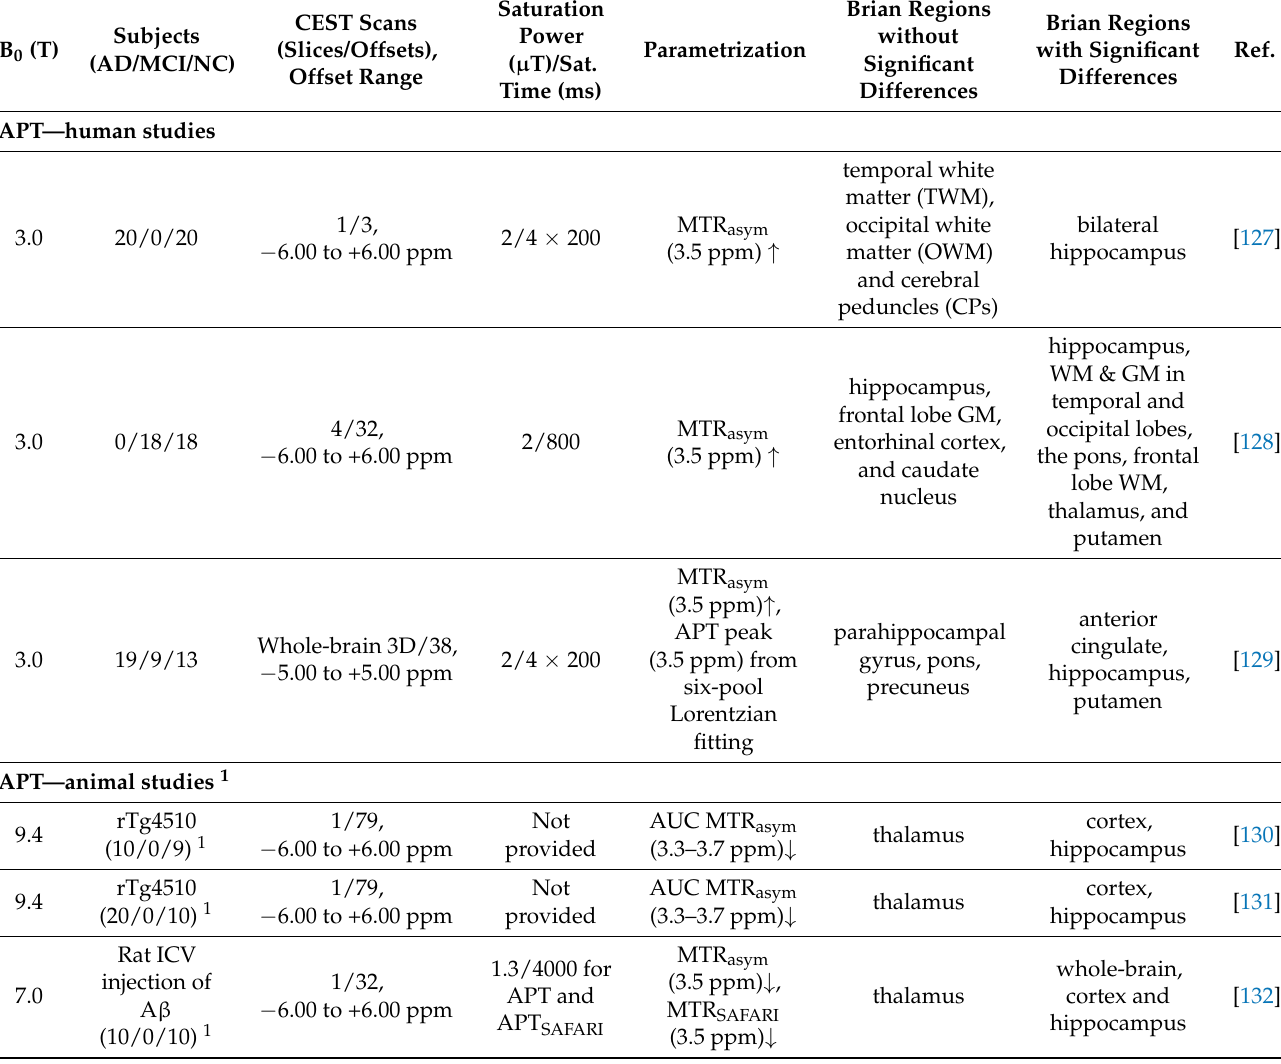
Table 4. Technical details of studies using APT imaging for studying both patients and animal models of AD. Patient studies have been conducted with similar acquisition setup and their results can be compared directly. The animal studies use different experimental and data analysis approaches, and thus it is difficult to discuss their results with respect to human